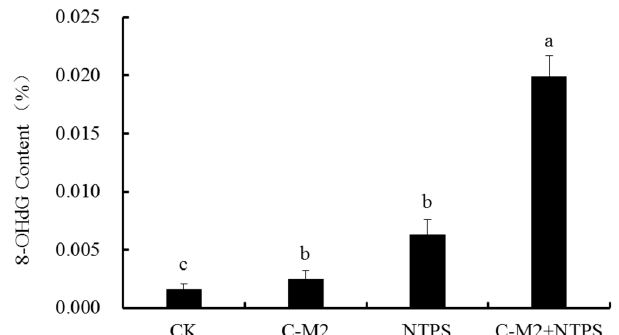
Figure 8. 8-OHdG contents produced in Morganella sp. wf-1 cells with di ff erent treatments. Di ff erent lowercase letters indicate significant di ff erences ( p <